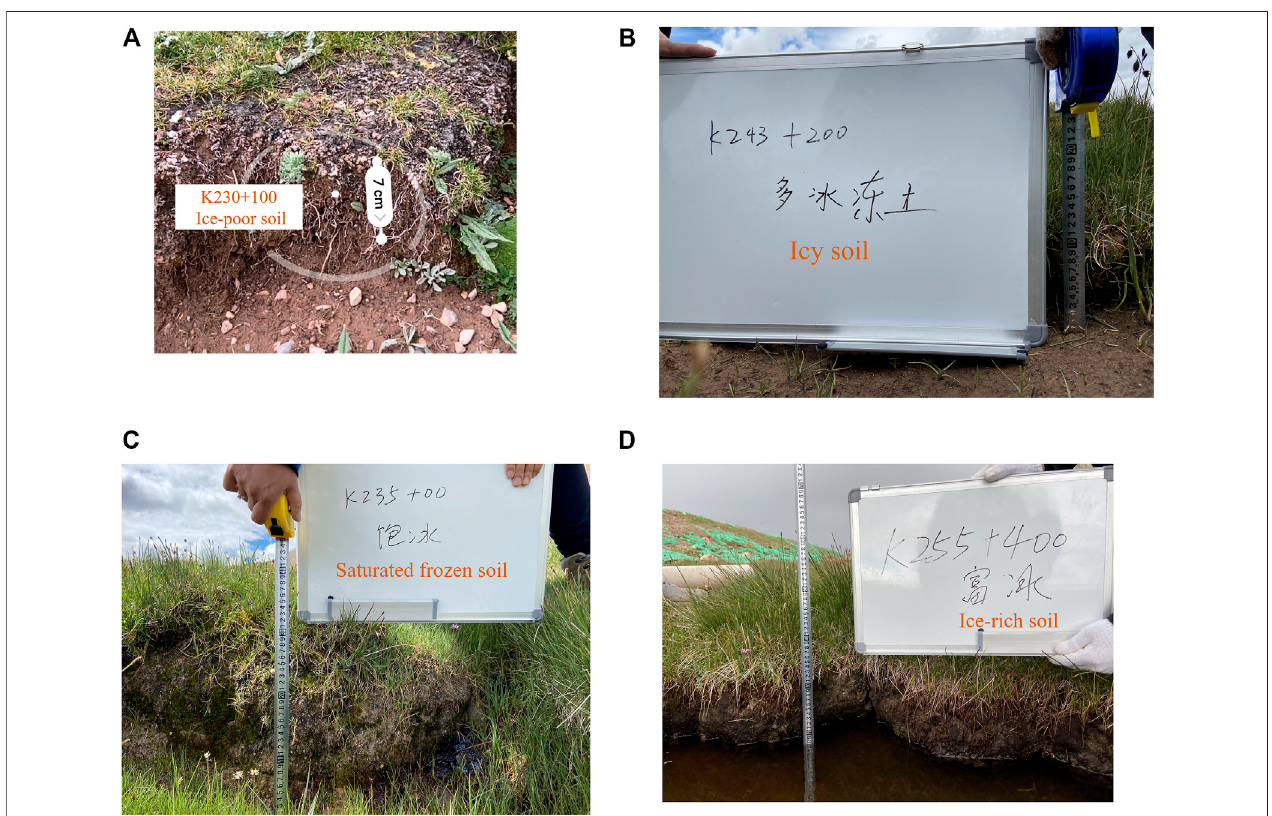
FIGURE 5 | Meadow development degree of different areas along the road. (A) Undeveloped ( h = 7 cm). (B) Basically developed ( h = 21 cm). (C) Developed ( h = 39 cm). (D) Fairly developed ( h = 55 cm).